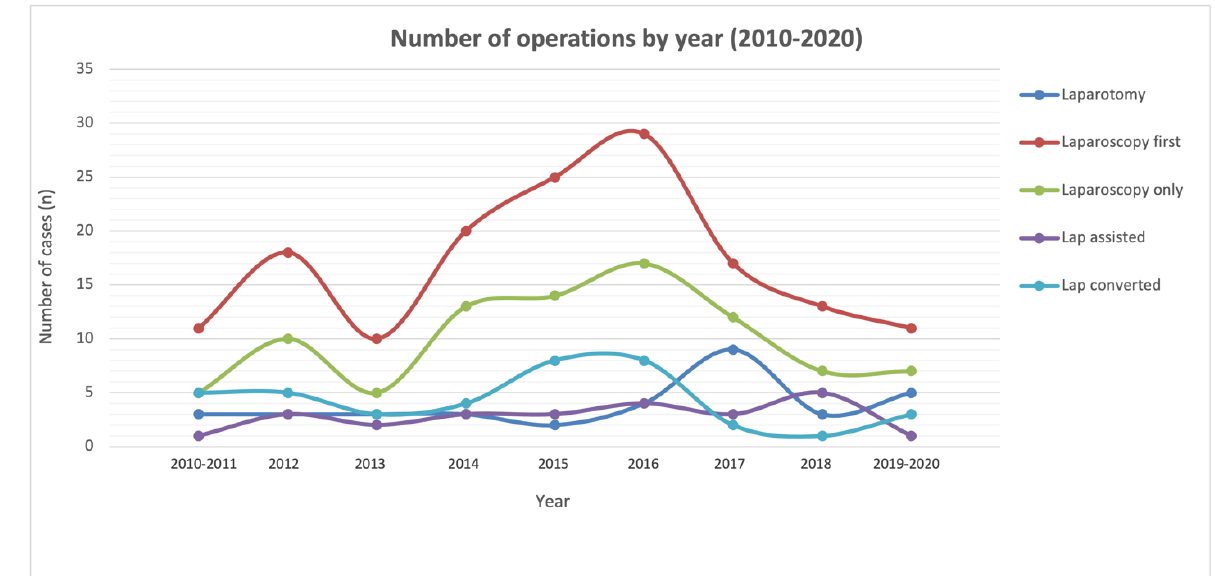
Figure 1. Learning curve of use of laparoscopy for acute SBO (2010 – 2020).